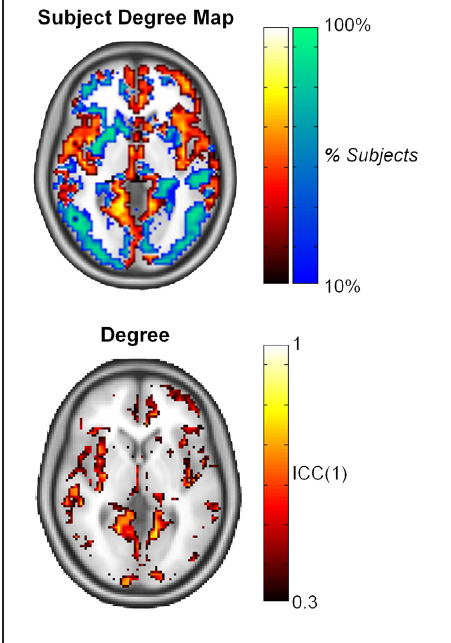
FIGURE 3 | Subject degree map reflects consistency of high degree nodes (top 25% in orange and yellow) and low degree nodes (bottom 75% in blue and green) across subjects. ICC scores at the nodal level were found to be consistent with region of high degree in the brain. This image was adapted from Telesford et al.